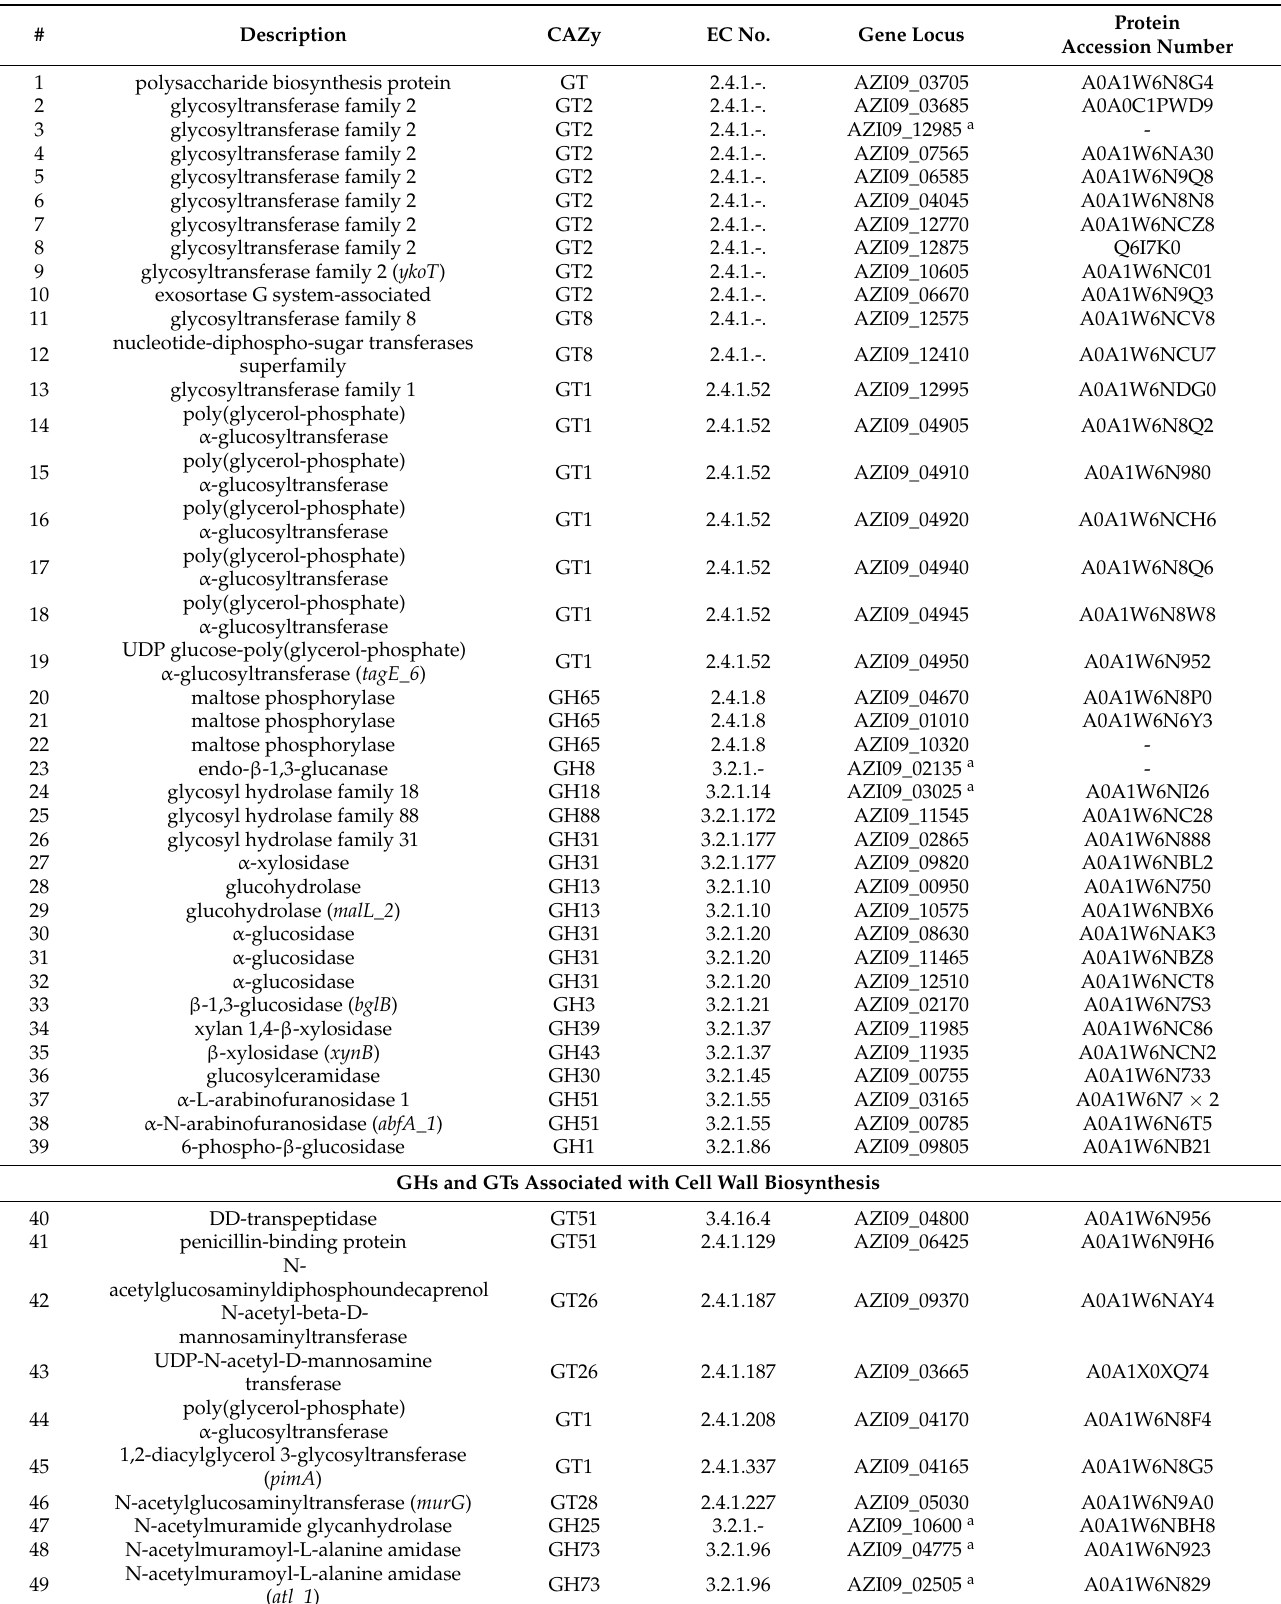
Table 1. GTs (EC 2.4.-) and GHs (EC 3.2.1.-) enzymes within the genome sequence of L. brevis TMW 1.2112